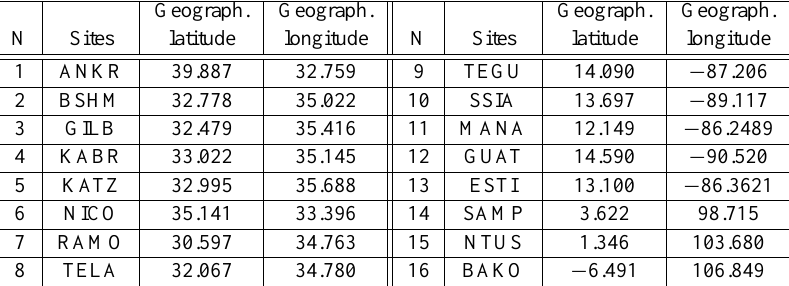
Geograph. latitude